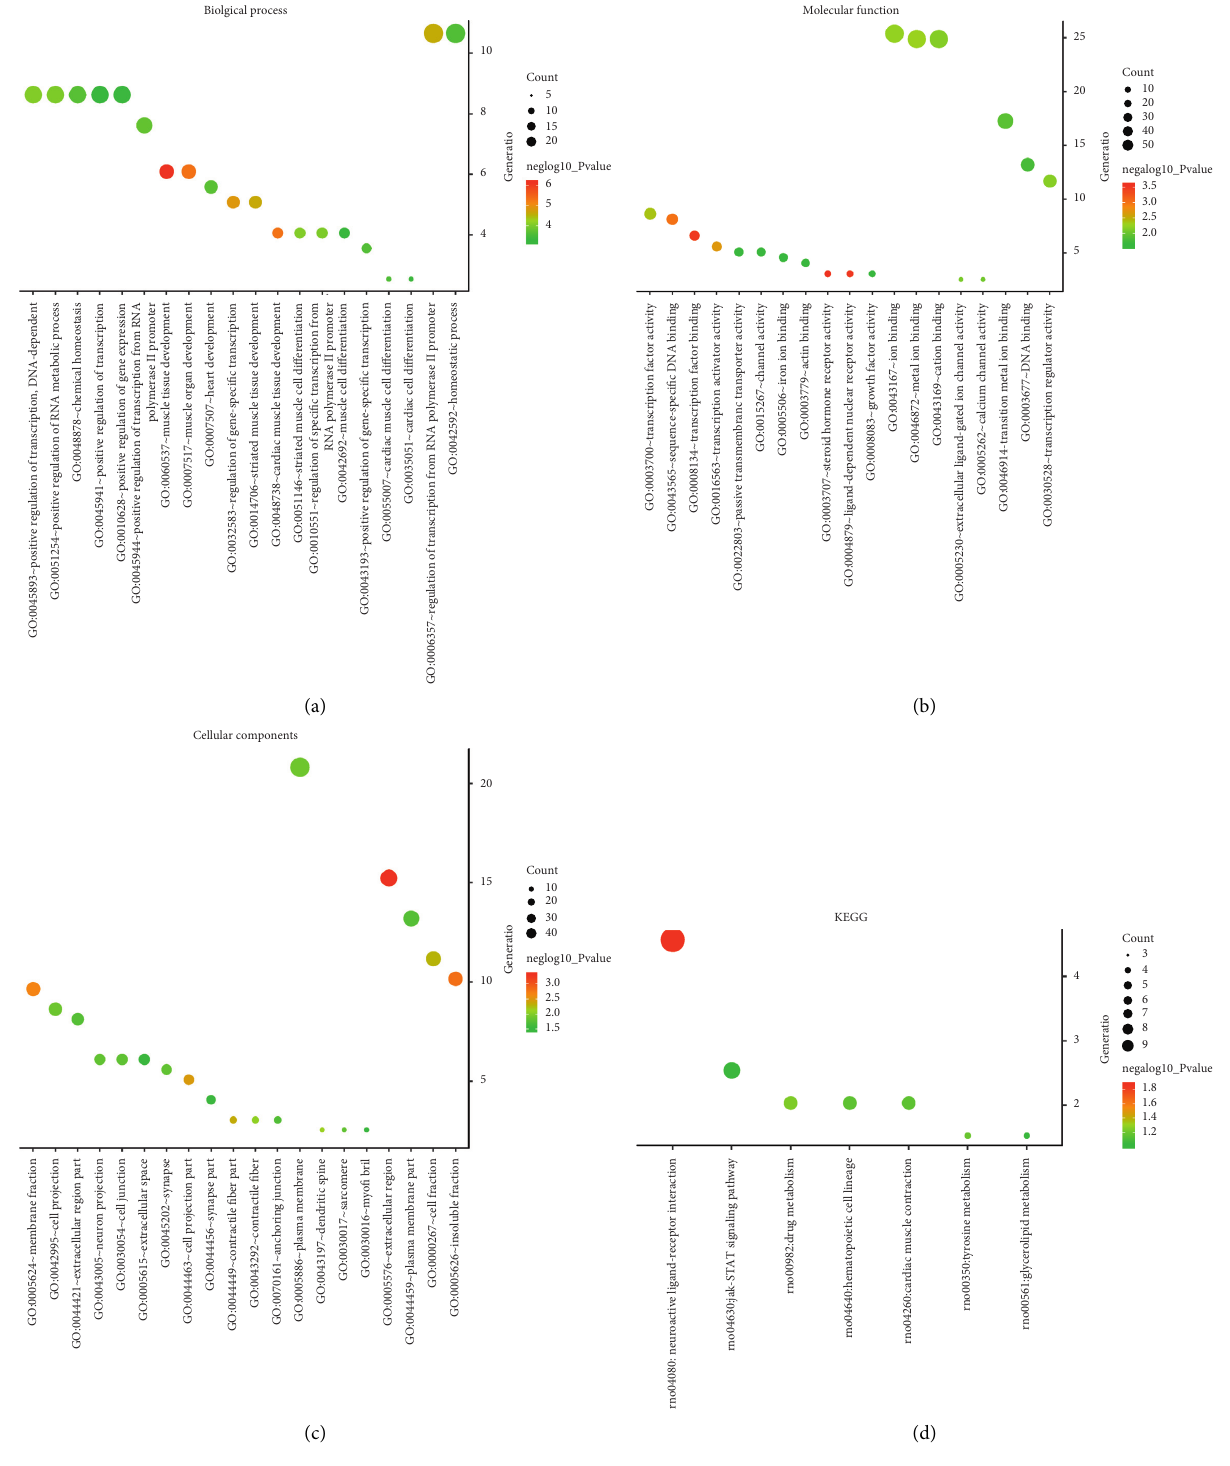
Figure 2: The enrichment analysis of DEGs by DAVID. The bubble charts showed (a) BP, (b) CC, (c) MF, and (d) KEGG,